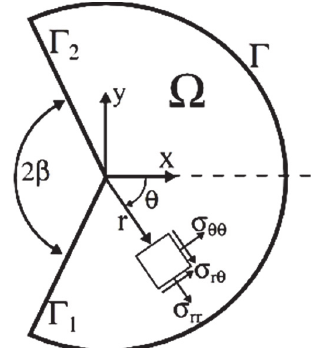
Figure 1: Domain Ω for the sharp V-notch problem